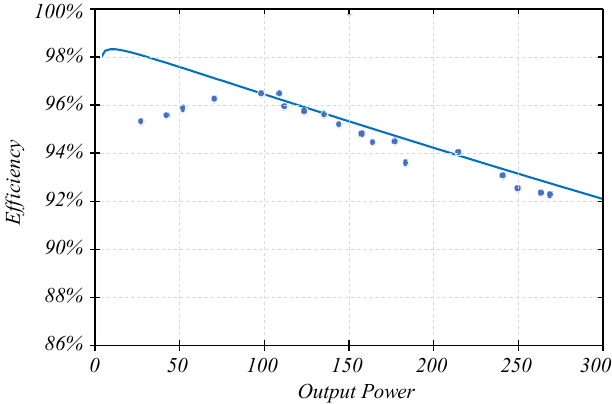
Figure 19. Calculated efficiency (line) and measured (points).